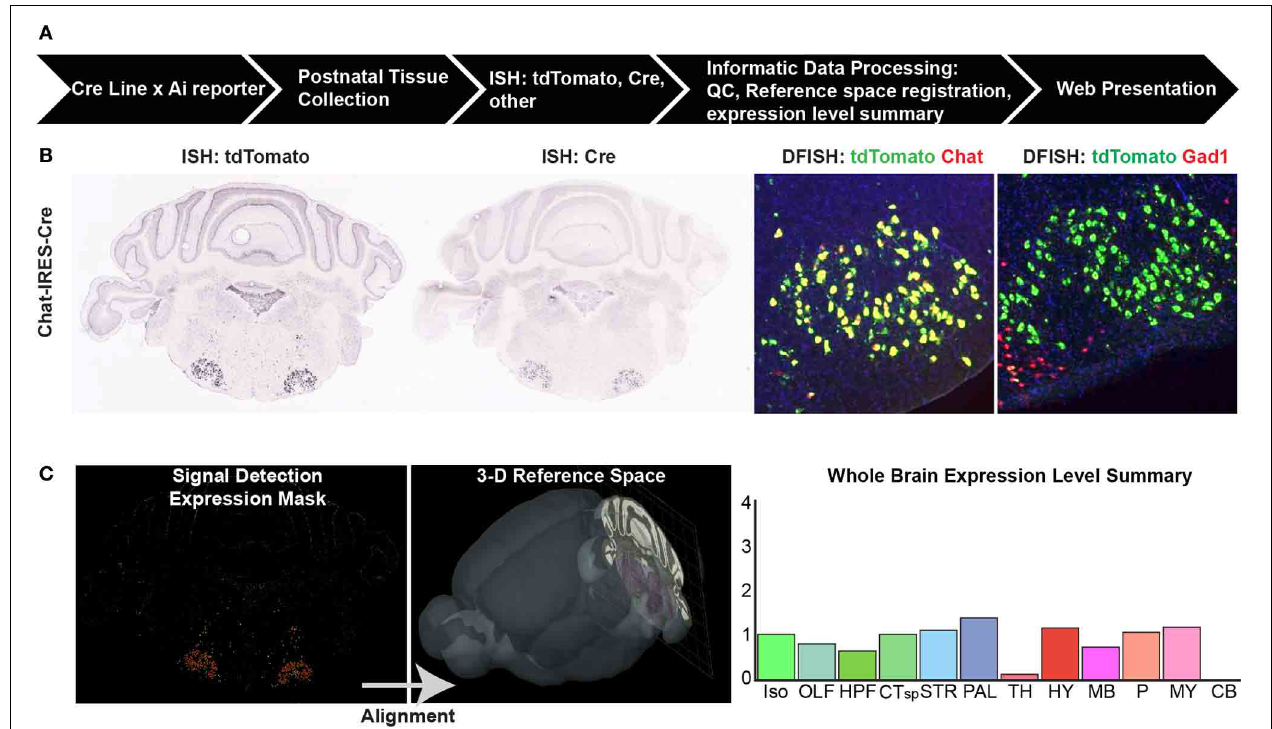
FIGURE 1 | Cre characterization data types and processing pipeline. (A) An overview of the high-throughput pipeline starting with crosses of mice from every characterized Cre line to a Cre reporter strain (e.g., Ai9, Ai14) to generate double positive mice for brain collection at up to four postnatal ages. The entire brain is sectioned and tissue subjected to in situ hybridization (ISH) before informatics data processing and web presentation. (B) Types of ISH data collected. For every Cre/reporter line, ISH was used to detect the tdTomato reporter gene at P56. For most Cre lines, additional data types include ISH to detect the Cre gene itself at P56, and double-fluorescent ISH (DFISH) using probes for the tdTomato gene and corresponding endogenous gene to the Cre line promoter or to another cell type marker